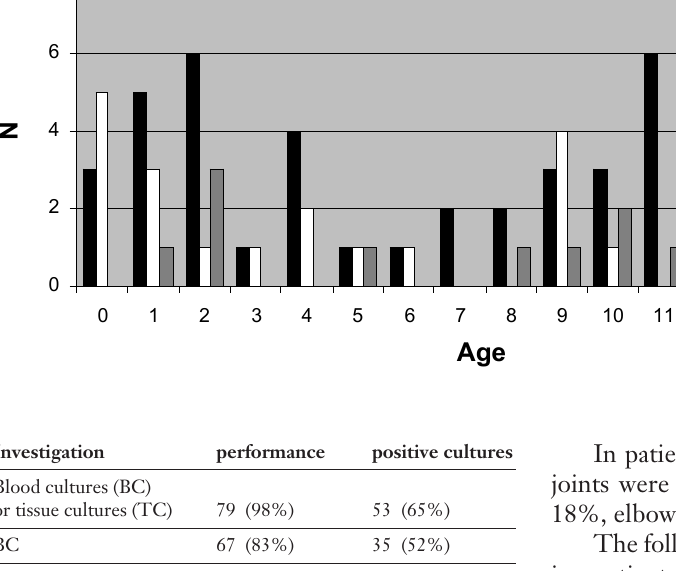
Figure 2 Age distribution of 81 patients with acute hematogenous osteomyelitis and/or septic arthritis.